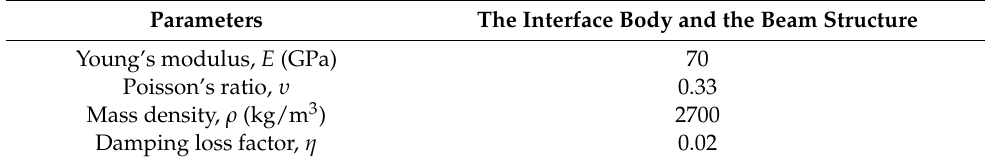
Figure 3. The finite element model of the fixed – fixed beam-like structure instrumented with a PZT interface at the center. Table 1. Mechanical properties of the interface and the host beam.